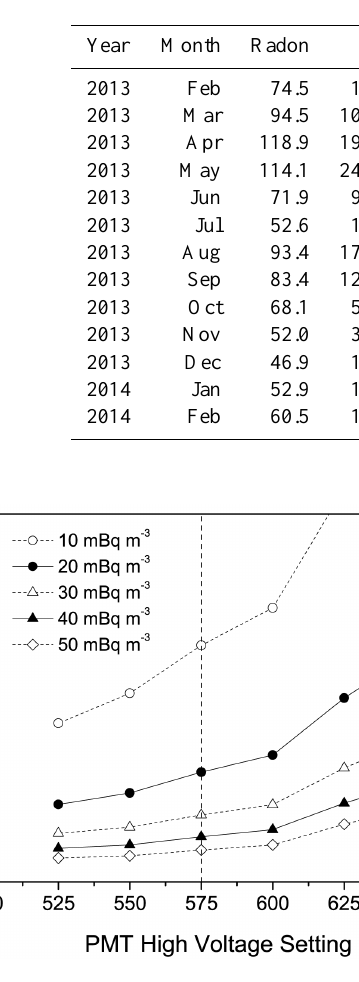
Figure 4. Relative counting error as a function of photomultiplier operating voltage for nominal radon concentrations between 10 and 50mBqm − 3 . The KSG detector’s current operating voltage is indi- cated with a vertical dashed